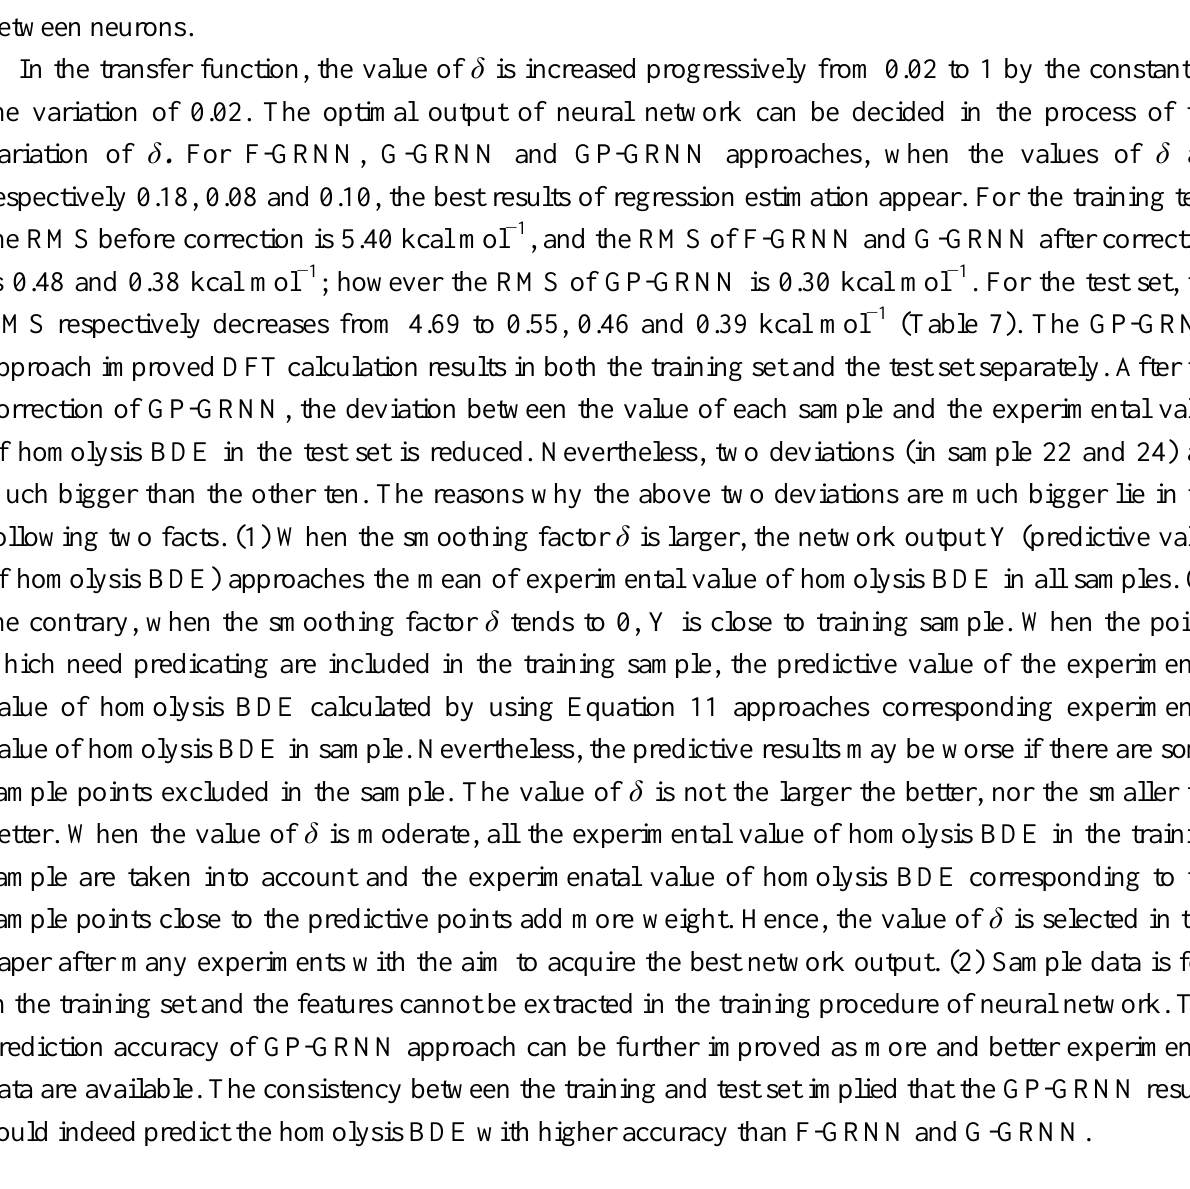
Figure 3a is the scatter diagram of the B3LYP/6-31G (d) results and experimental results. The vertical coordinates are the experimental values and the horizontal coordinates are the B3LYP/6-31G (d) calculated values. The diagonal line represents that the vertical coordinate and horizontal coordinates are equal. In Figure 3b, Figure 3c and Figure 3d the horizontal coordinates represent the correction results of F-GRNN, G-GRNN and GP-GRNN, respectively. It can be seen that the correction results of GP-GRNN are closer to the experimental values. The insets are the histogram for the deviation of three approaches in Figures 3a–3d. It is obvious that B3LYP/6-31G (d) approach has large systematic